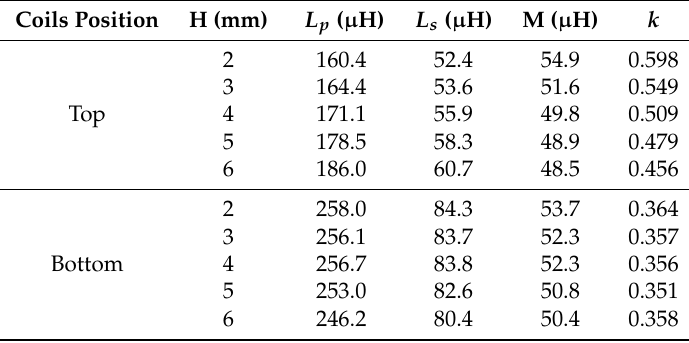
Table 1. Electromagnetic parameters of the coupler. ( l g = 10